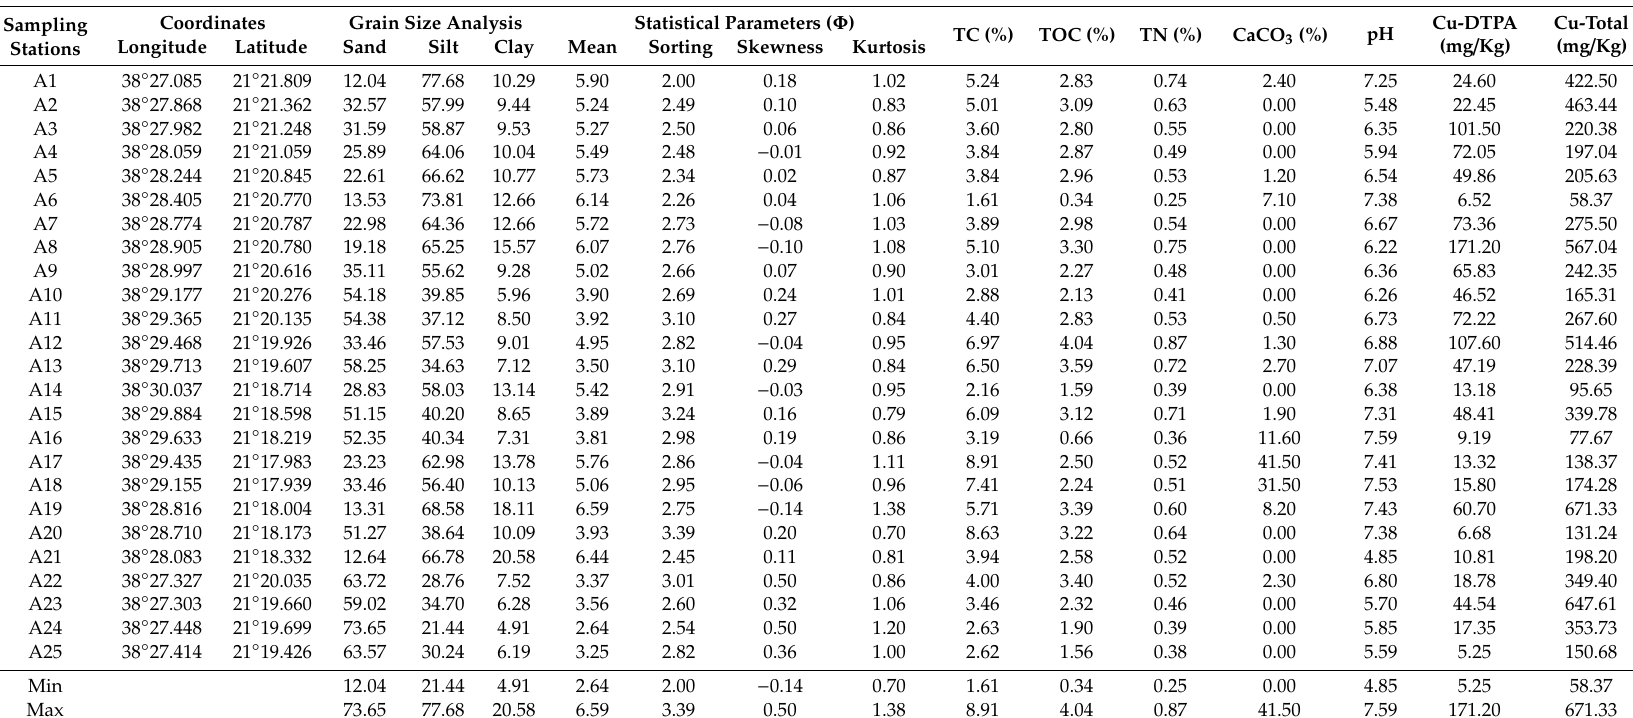
Table 1. Sedimentological and geochemical analyses of the Aetoliko olive orchard soil